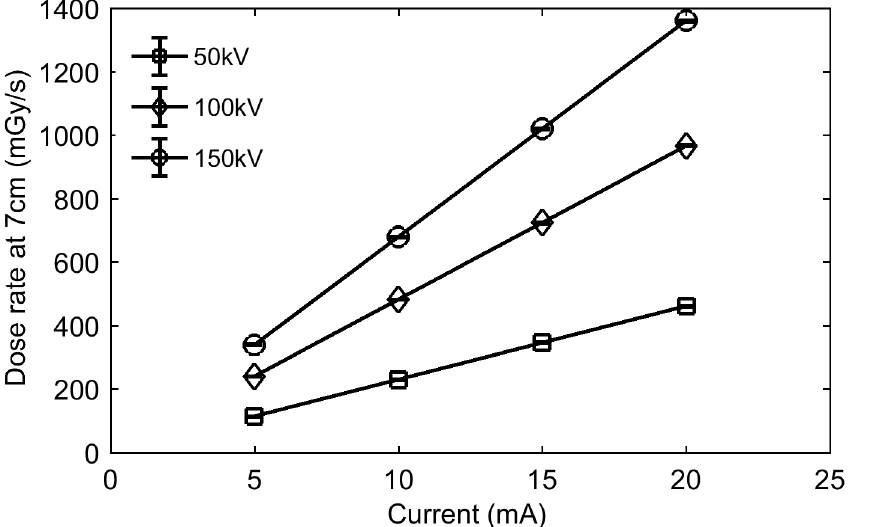
Fig 1. Dose rate in air measured70 mm from the source as a function of